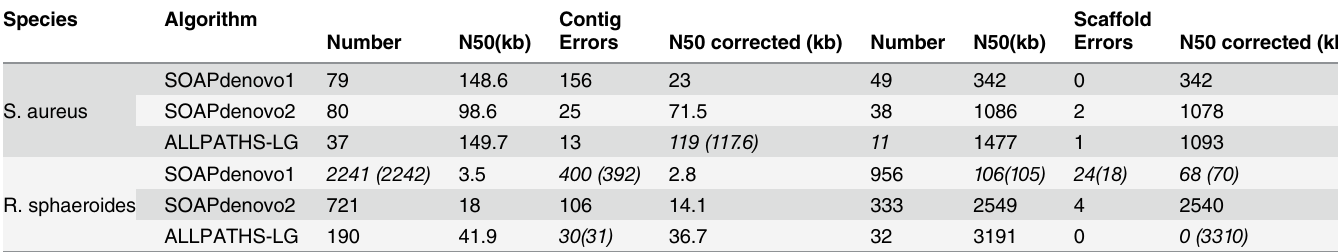
Table 1. Results from reproducing Table 2 of the original paper, where the original results are shown in between parenthesis. Species Algorithm